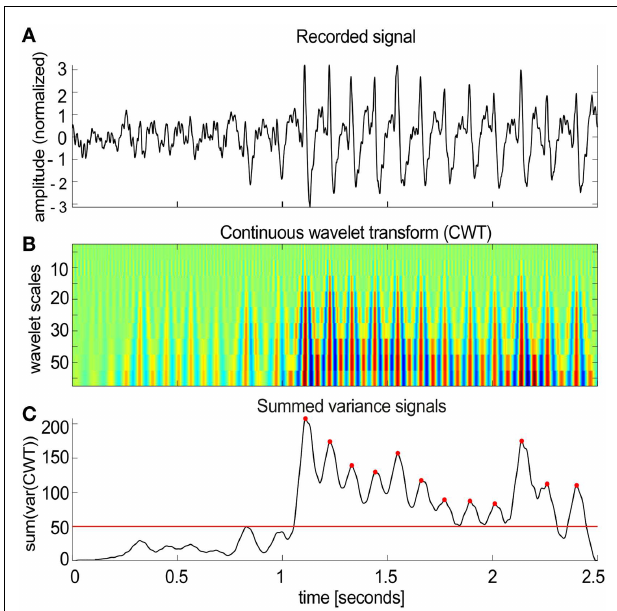
FIGURE 2 | Spike-wave activities in NVHL and control rats . (A) A segment of the cortical EEG with spike-wave activity. An automatic classifier was used to detect these events. (B) The first step in the classifier was to transform the recorded signal using the continuous wavelet transform (CWT). (C) Then a sliding variance was computed for each wavelet scale. All the variances were summed across all scales resulting in a single variance profile over time (50ms smoothing was applied to the resulting signal). SWD candidates were detected as threshold crossings [red line in (C) ]. Each marked segment was tested for periodic spiking activity by detecting local maxima [red dots in (C) ]. Only the detected segments that contained at least 50% of inter-spike intervals in the range of 2–10Hz were included in further